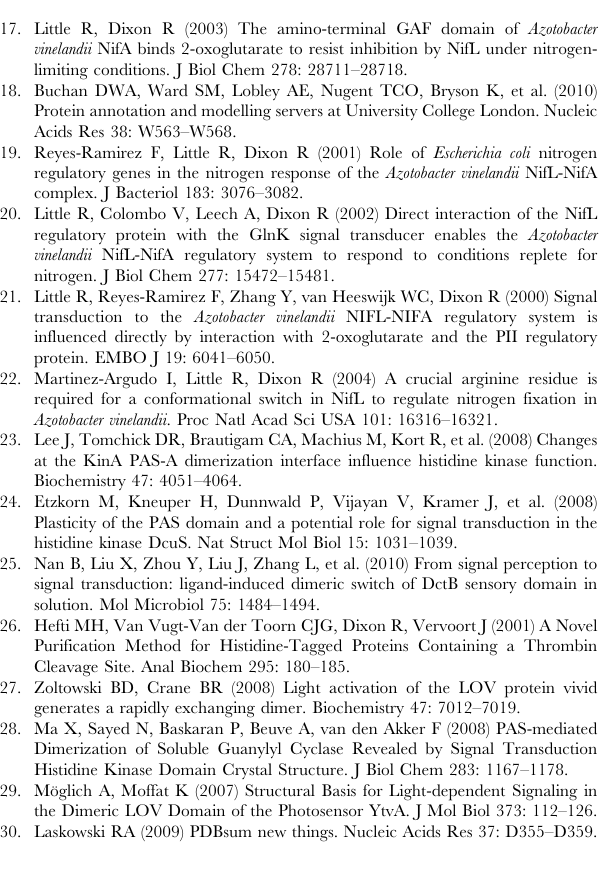
Table S1 Influence of amino-terminal flanking residues on oligomerisation state in the 1–162 PAS1 construct of